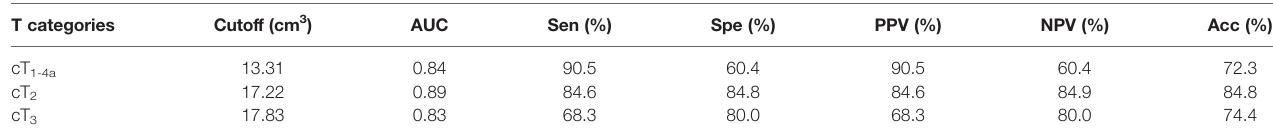
TABLE 3 | Receiver operating characteristic analysis of tumor stage-based gross tumor volume for predicting early recurrence of esophageal squamous cell carcinoma in the training cohort.